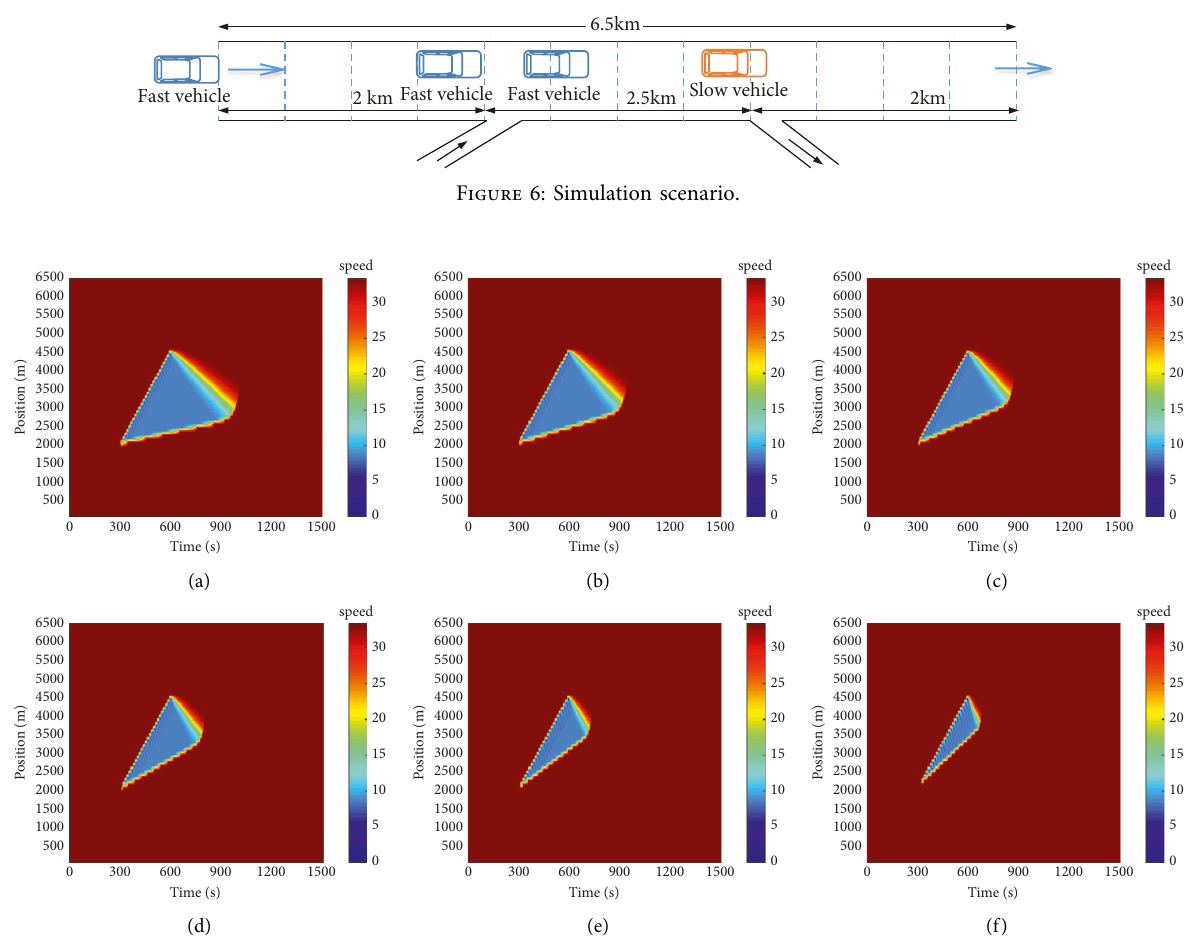
Figure 7: Speed heat map based on CTM model of mixed traffic flow: (a) p � 0, (b) p � 0 . 2, (c) p � 0 . 4, (d) p � 0 . 6, (e) p � 0 . 8, and (f) p �